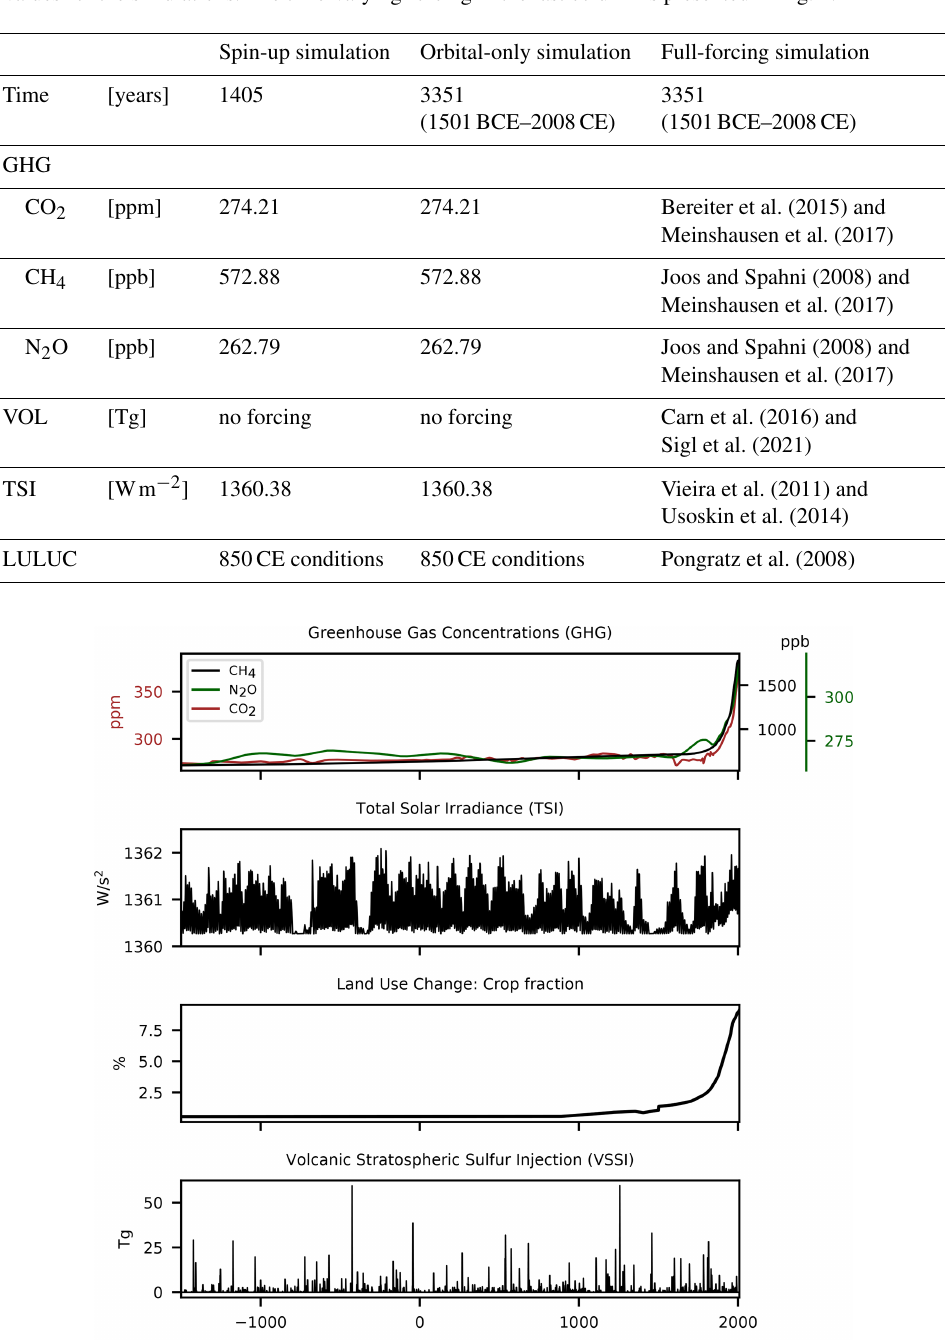
Figure 1. Time series of the external forcing included in the transient full-forcing simulation for 1501BCE–2008CE.